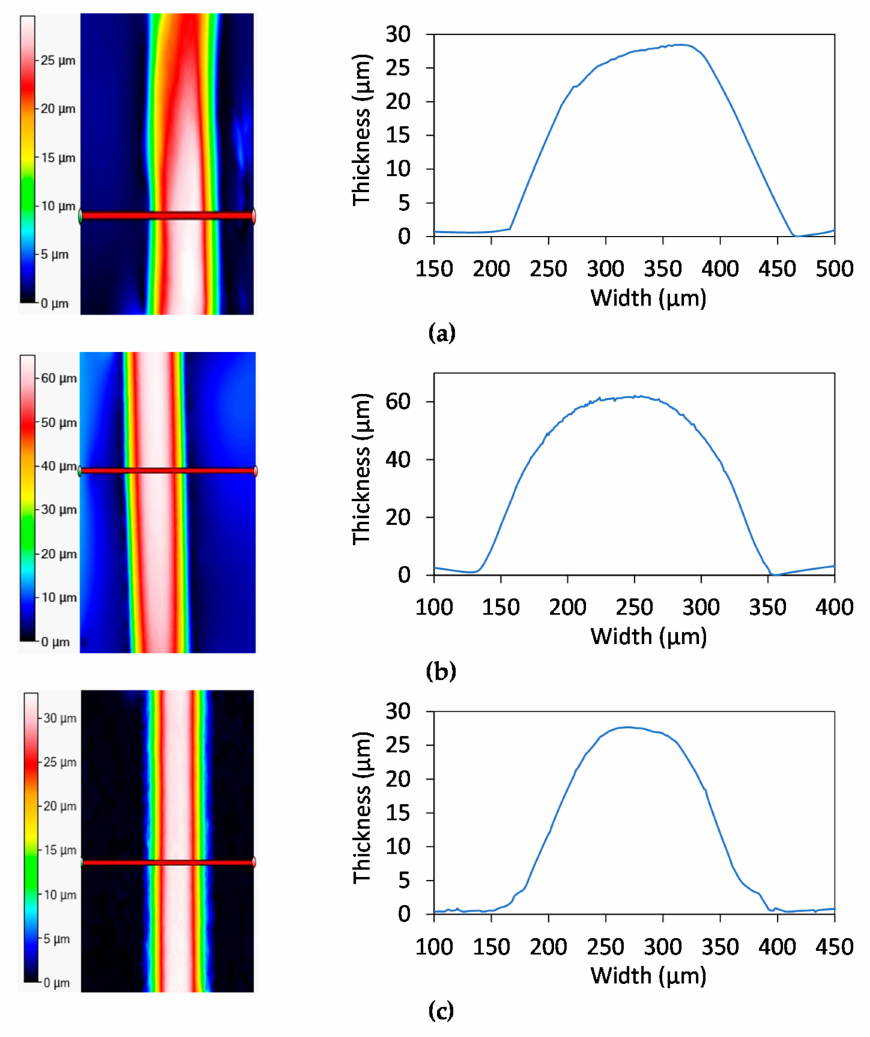
Figure 7. ThicknessprofileforAgon( a )chromatographicpaper, ( b )cardboard, and( c